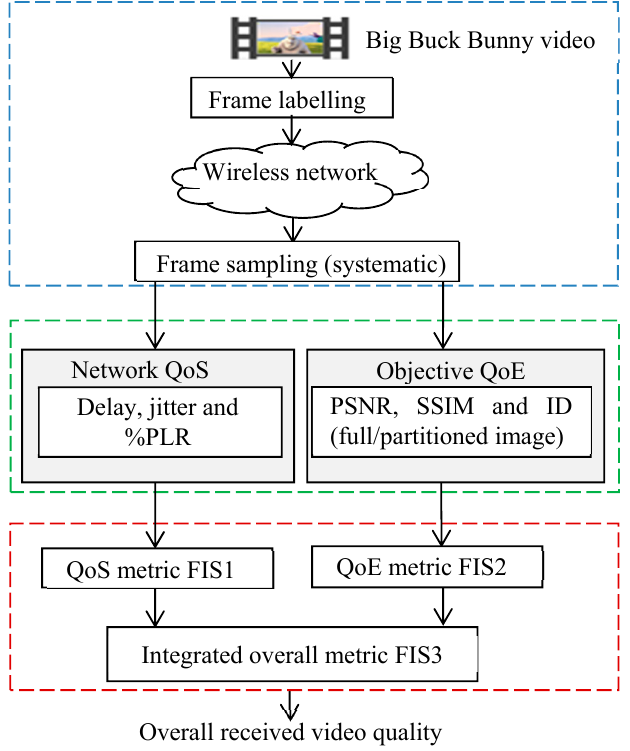
Figure 3. Stages to determine the received video quality.